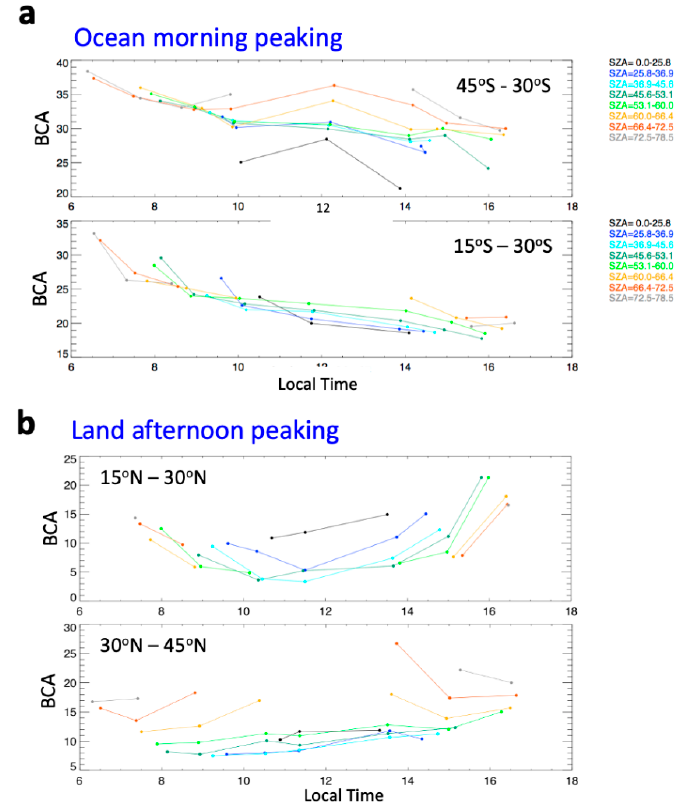
Figure 4. ( a ) The BCA daily cycle for clouds in the ocean morning-peaking geographic bin sorted by solar zenith angle. SBUV observations from red-colored grid cells over the ocean in Figure 2a are used. ( b ) The BCA cycle for land afternoon-peaking clouds. The SBUV observations from blue-colored grid cells over land in Figure 2a are shown here.